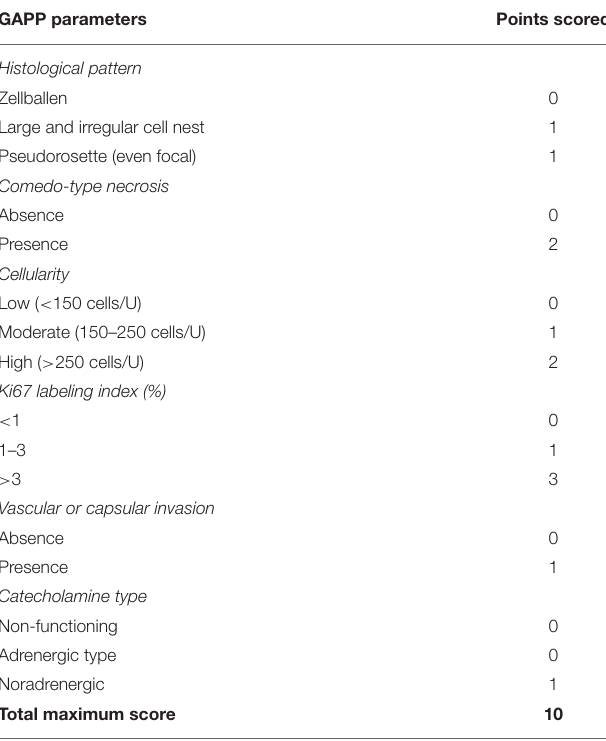
TABLE 3 | The grading system for adrenal pheochromocytoma and paraganglioma (GAPP score). GAPP parameters Points